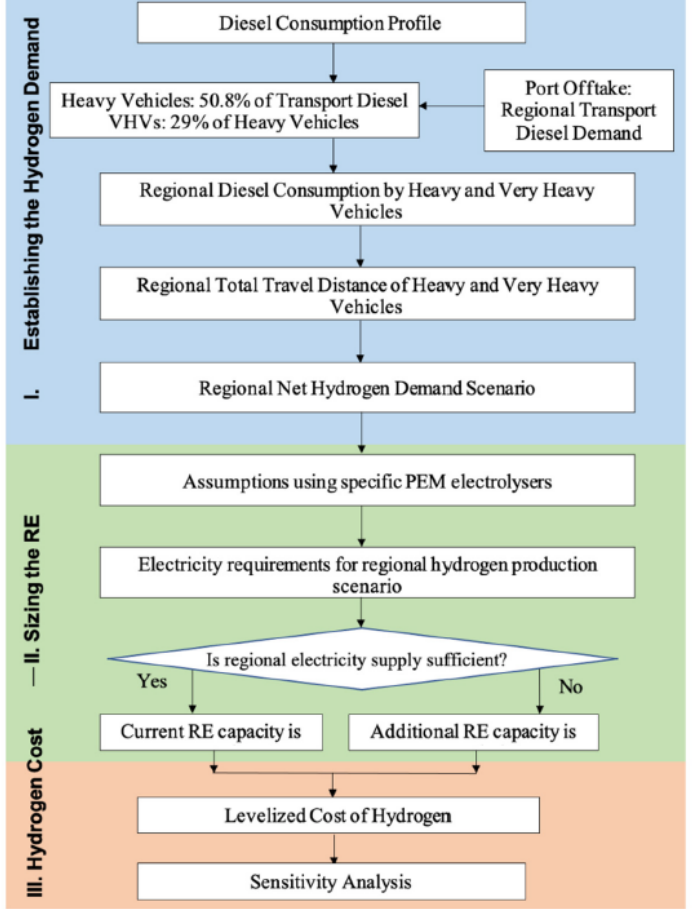
Figure 1. Methodology schematic